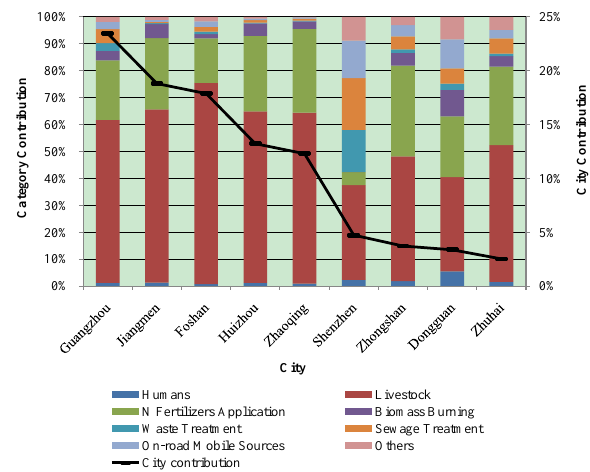
Fig. 5. Source contributions by cities in the PRD region for the year of 2006.